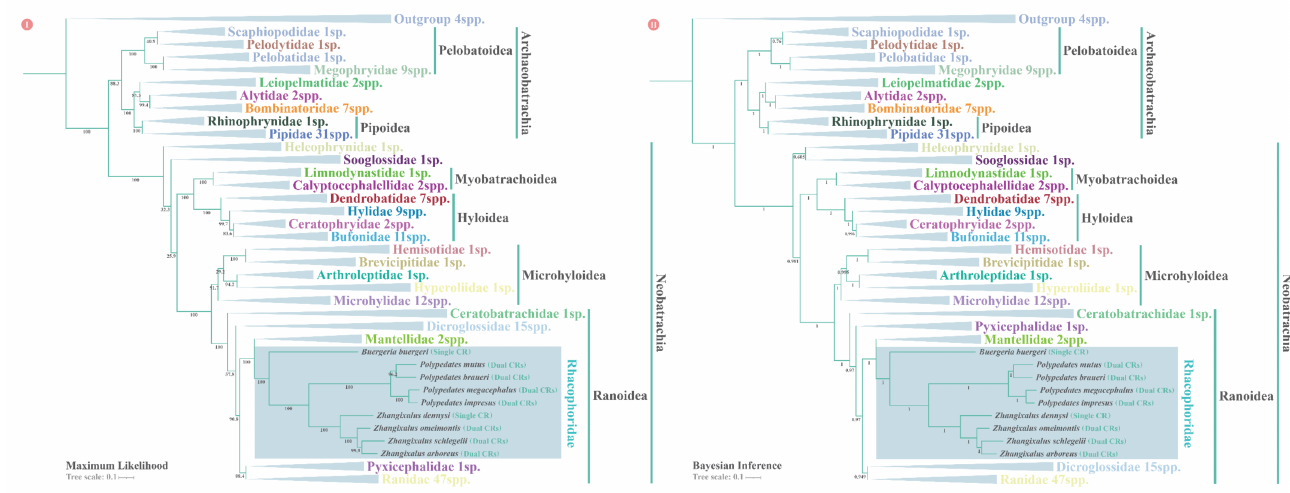
Figure 9. Phylogenetic tree for 185 species inferred from nucleotide sequences of 13 protein-coding genes (PCGs) and two rRNA genes of the mitogenome with maximum likelihood (ML) ( I ) and Bayesian inference (BI) ( II ) analyses. The numbers below the branches represent the bootstrap proportion (BP) and posterior probability (PP) values. All the families except Rhacophoridae are collapsed for concise presentation. Detailed topologies of species within each family can be accessed in Figures S1 and